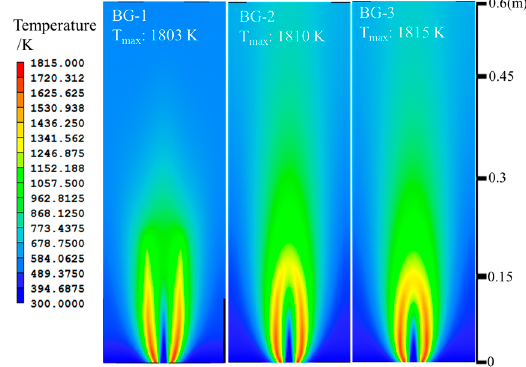
Figure 3. Effect of CH 4 content in biogas fuel on combustion temperature distribution.